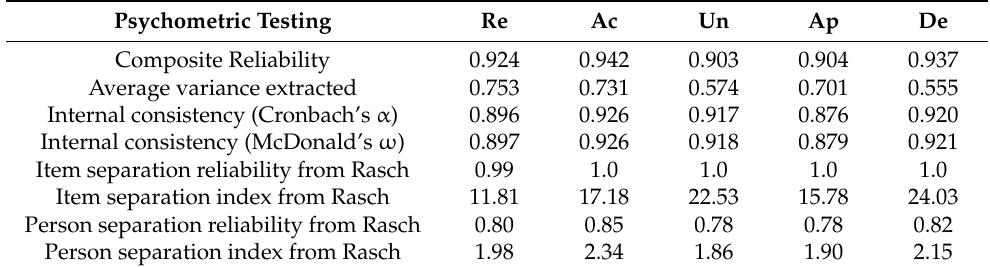
Table 3. Psychometric properties of the Health Literacy Instrument for Adults at the scale